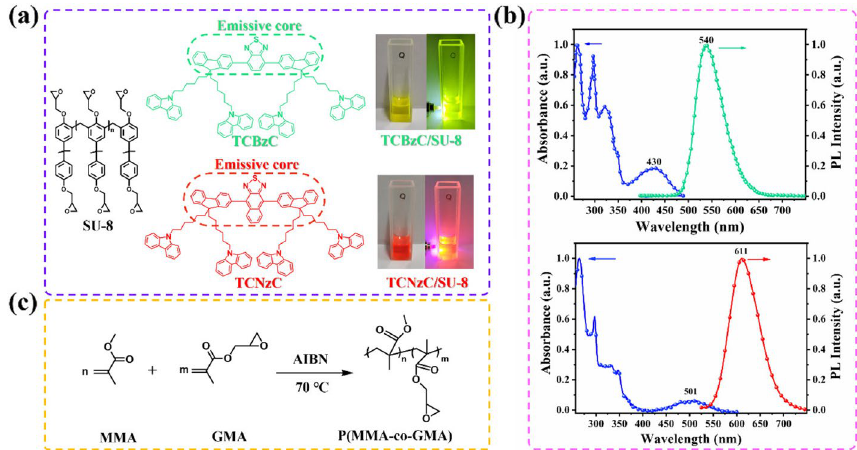
Fig. 1 a Molecular structures of SU-8, TCBzC, and TCNzC. The transparent TCBzC/SU-8 and TCNzC/SU-8 solution as the waveguide gain medium; b optical absorbance and PL spectra of TCBzC and TCNzC, respectively; c the synthesis process of P(MMA-co-GMA) cover cladding